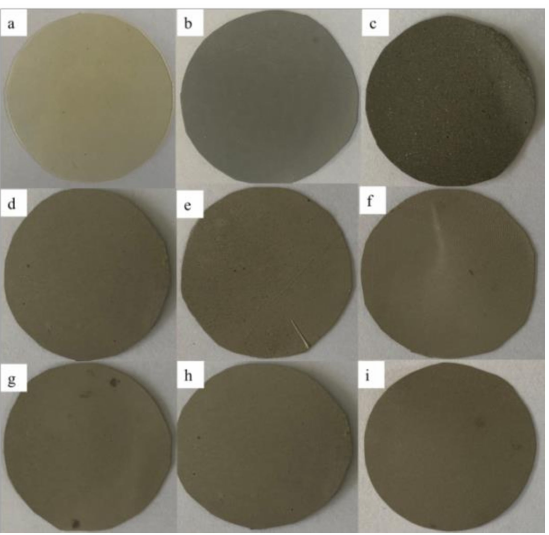
Figure 5. Photographs of the AgNWs-RGO-DA-PU composite films with the AgNWs-RGO mass contents of 0 wt% ( a ), 5 wt% ( b ), 10 wt% ( c ), 15 wt% ( d ), 20 wt% ( e ), 25 wt% ( f ), 30 wt% ( g ), 35 wt% ( h ), and 37 wt% ( i